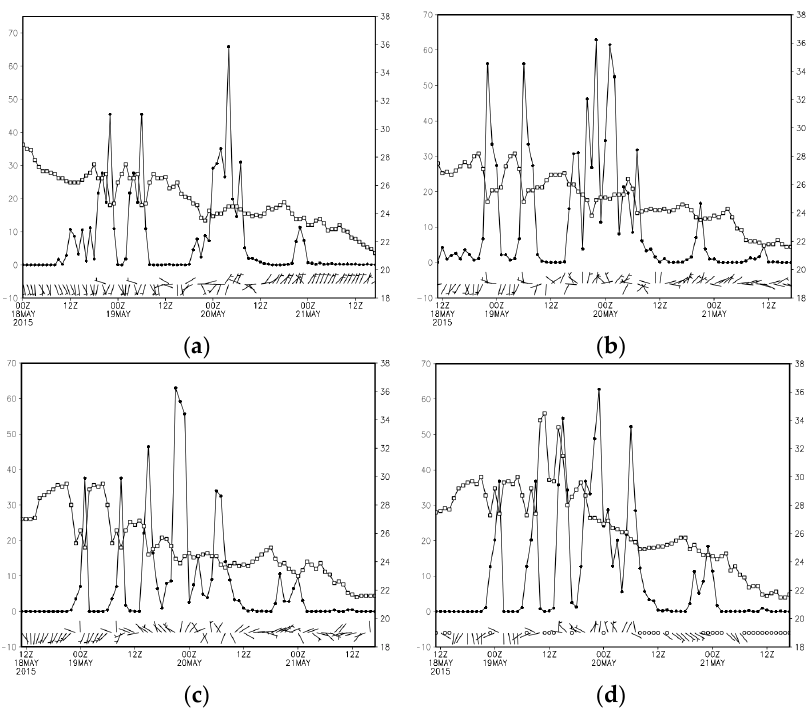
Figure 2. Time series of the hourly precipitation, temperature, and horizontal wind at four weather stations in the WSTR: ( a ) Haifeng, ( b ) G1803, ( c ) G1827, and ( d ) G1847. The line with empty squares represents the temperature, and the line with filled dots represents the precipitation.